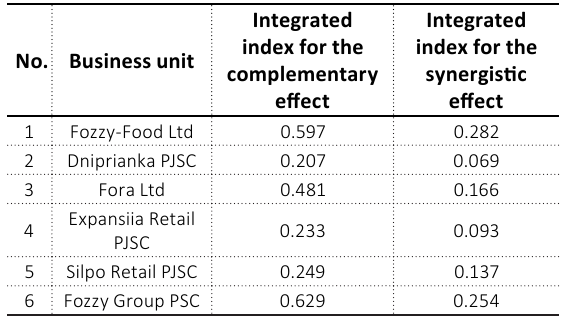
Table 4. Integrated indices of complementary and synergistic effects for Fozzy Group business units No. Business unit